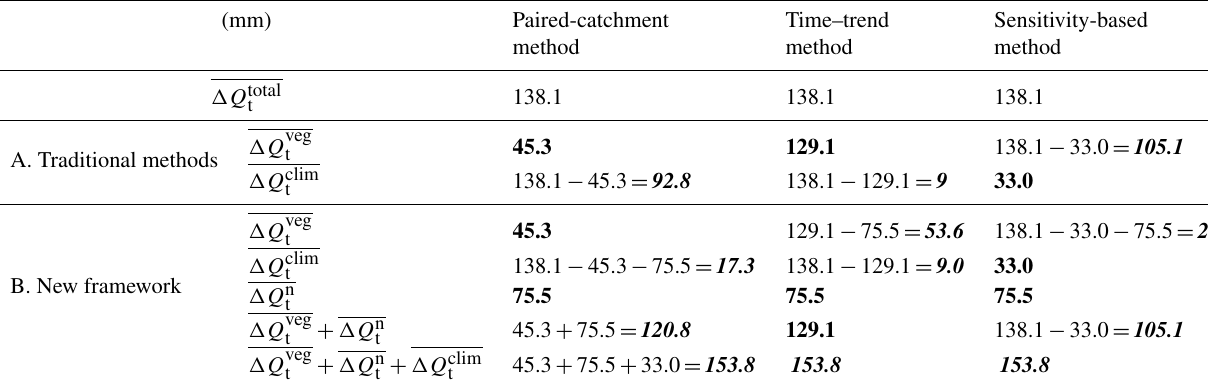
Table 2. Total runoff reduction ( (cid:49)Q total t ) and runoff reduction caused by vegetation change, climate variability, and hydroclimatic non-